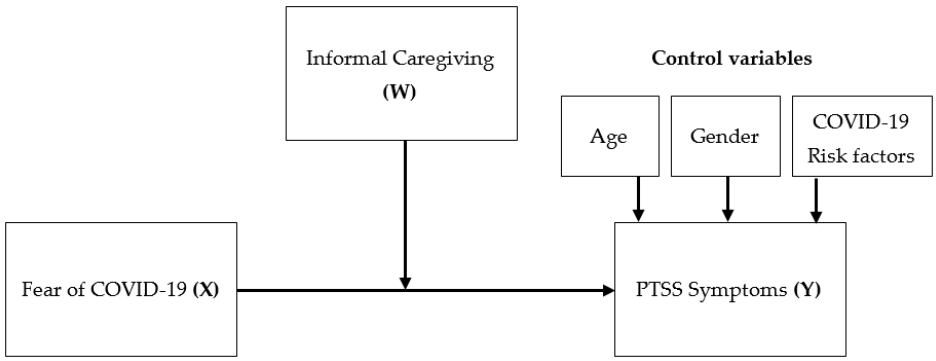
Figure 1. Conceptual diagram of the moderation model.